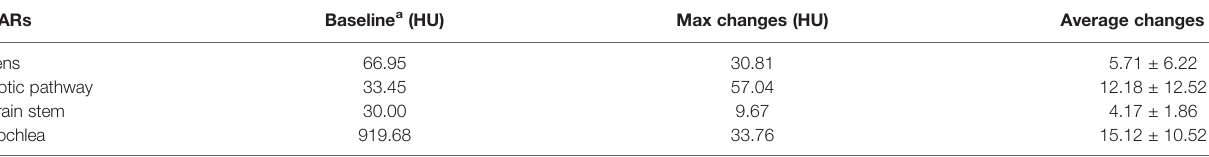
TABLE 4 | HU change of OARs due to CA injection.